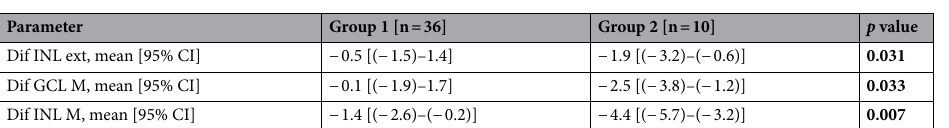
Table 3. Differences from 12 months follow-up to baseline of the different ETDRS subfields. Group 1 = non vitrectomized; Group 2 = vitrectomized; GCL = Ganglion cell layer; INL = inner nuclear layer; ext = outer ring ETDRS subfields; M = the nine ETDRS subfields; 95% CI = 95% Confidence interval. Only statistically significant differences are reported. All significant values are represented in bold. A p < 0.05 was considered statistically